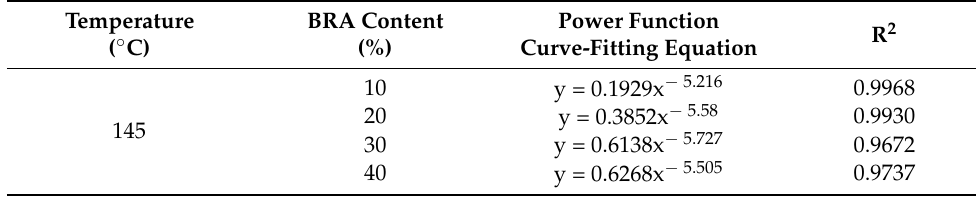
Table 4. Power function curve-fitting equation and R 2 of